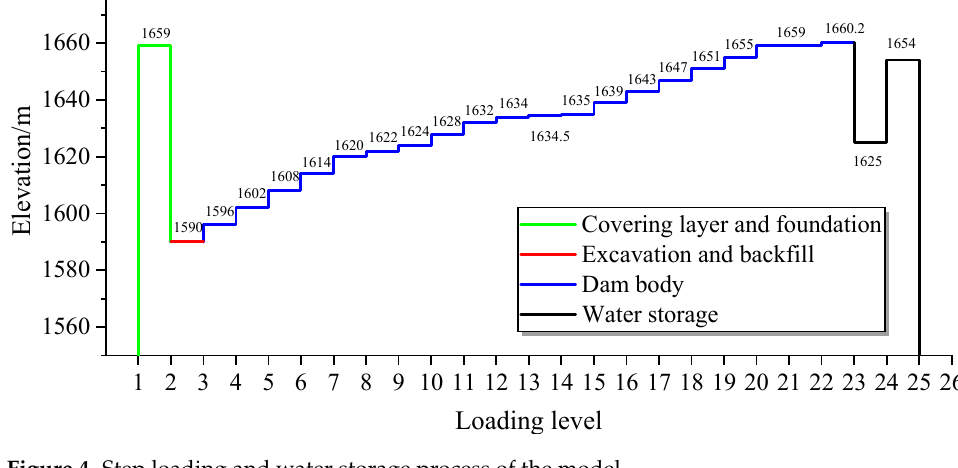
Figure 4. Step loading and water storage process of the model.